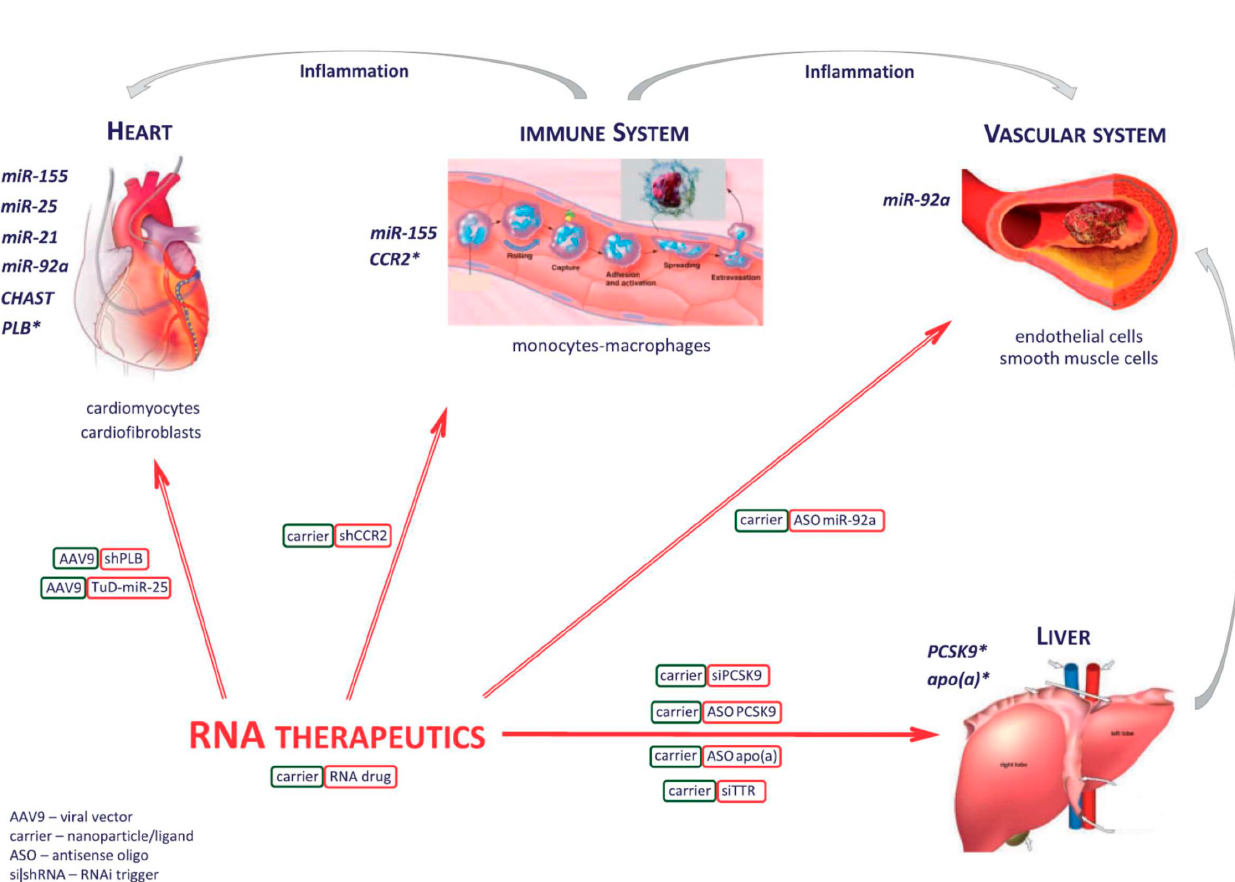
Figure 4. Novel nucleic acid therapeutics targeting conventional protein-coding genes or noncoding RNA targets (reprinted from Poller et al. Eur. Heart. J. 2018 [ 1 ] by permission). Cardiovascular RNA drugs address multiple organ systems. RNA drugs do not need to address heart (A) or vasculature (B) directly. Instead, primarily liver-targeted RNA drugs (C) are the currently most successful development in the cardiovascular field. Another group of strategies addresses the immune system (D), in particular monocytes-macrophages. ’Carrier’ denotes a synthetic nanoparticle and/or receptor ligand employed to deliver an RNA drug to its tissue target. ‘Carrier’ is bound to and serves to stabilize the RNA drug within the circulation, and to endow it with at least partial selectivity for the target cells, in order to minimize side effects. ‘AAV9’ denotes a cardiac-targeting recombinant adeno-associated viral vector containing a genome from which the therapeu-tic RNA sequence is continuously transcribed. Molecular targets: apo(a), apolipoprotein (a); CCR2, chemokine C-C motif receptor 2; CHAST, Cardiac hypertrophy associated transcript; PCSK9, proprotein convertase subtilisin/kexin type 9; PLB, phospholamban. ( modified from ref. 1 by permission of Eur. Heart J .).